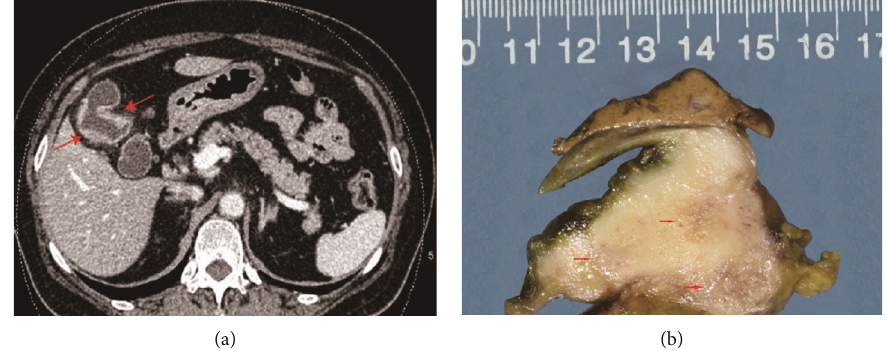
Figure 1: (a) An abdominal contrast-enhanced CT scan showing di ff use thickening of the gallbladder wall, with signi fi cant enhancement (arrows) in the portal venous phase. (b) Gross image of the gallbladder showing a thickened wall; the cut surface shows a tan-white thickened submucosal layer (arrows) invading through the wall into the surrounding adipose tissue, which did not invade the adjacent liver